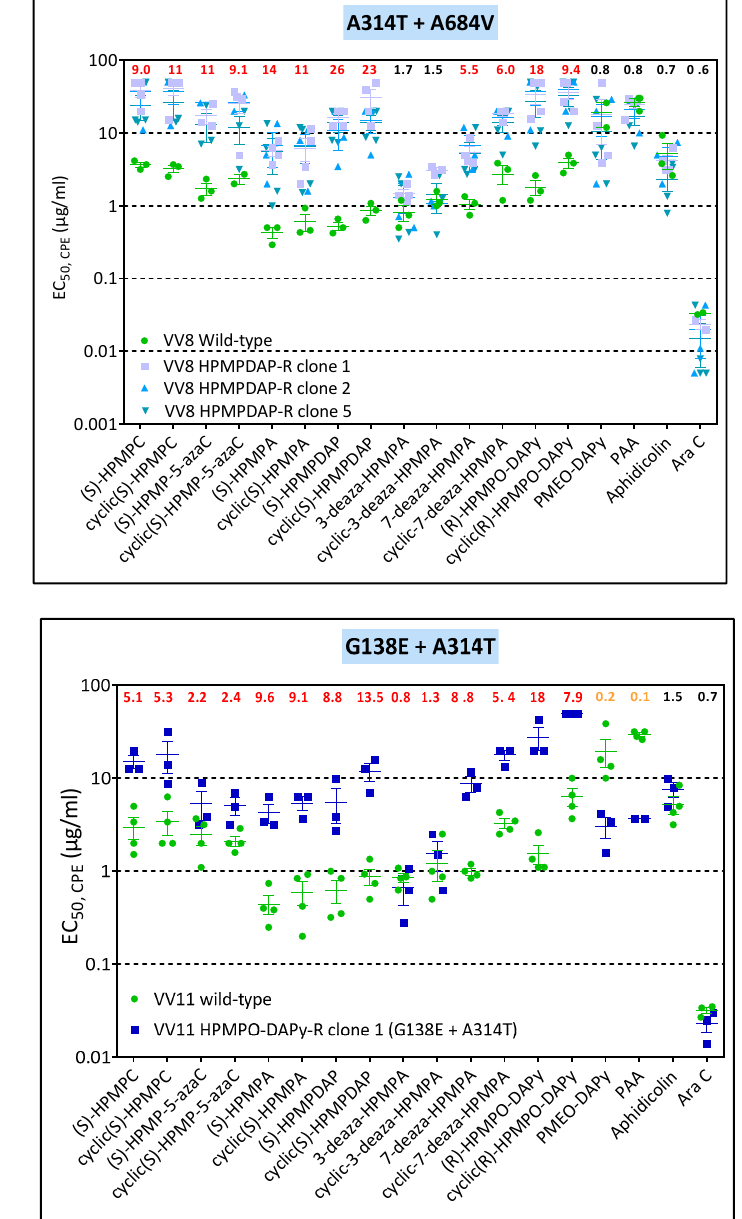
Figure 6. ( A ) Drug-susceptibility profile of selected viral clones to evaluate the impact of the A314T, M656I, A684V, and L696S DNA polymerase substitutions. The source of the viral clones was as follows: A314T (VV8 HPMPDAP-R #8), A314T + A684V (VV8 HPMPC-R #30), A314T + L696S (VV11 #16), A314T + M656I + A684V (VV11 HPMPC-R #40), and A314T + A684V + L696S (VV11 HPMPDAP-R #39). ( B ) Drug-susceptibility profile of the selected VV11 HPMPO-DAPy-R viral clone bearing the G138E + A314T mutations. Drug-resistance properties of the different types of viral clones were determined using a CPE reduction assay with HEL fibroblasts. The effects of different drugs on viruses encoding the indicated mutations were determined by calculating the EC 50 values for the parental wild-type strain and clones bearing the specific mutations. At least two independent experiments were performed for each test compound. Horizontal lines for each drug and mutant viral clones indicate the mean values ± standard deviation. The fold resistance (ratio of the EC 50 for the mutant viruses to the EC 50 for the corresponding wild-type virus is marked at the top of the graph. VACV viral clones showing a ≥ 2-fold increase (red, bold) were considered drug resistant (R) and those with a ≤ 0.5-fold decrease (orange, bold) drug hypersensitive